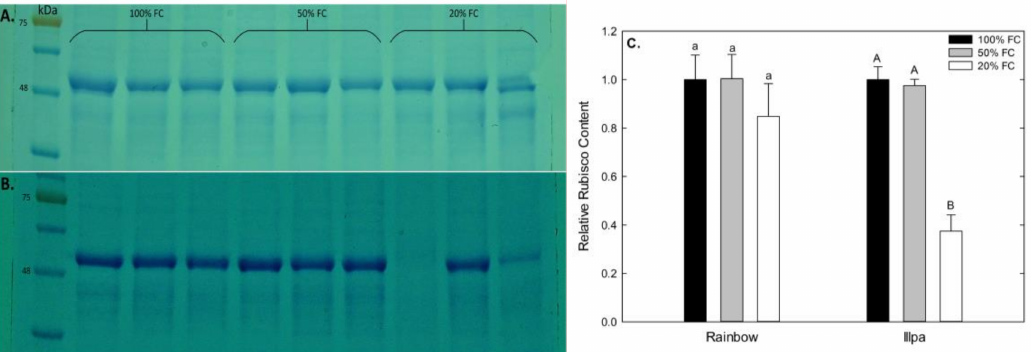
Figure 5. Rubisco detected by Western Blot in ( A ) Rainbow and ( B ) Illpa cultivar grown under irrigation regimes of 100% substrate holding full capacity (FC), 50% FC or 20% FC. ( C ) Relative Rubisco content in both cultivars. The same letters indicate no significant di ff erences between treatments for a given cultivar ( p < 0.05). Mean ± SE ( n = 3).